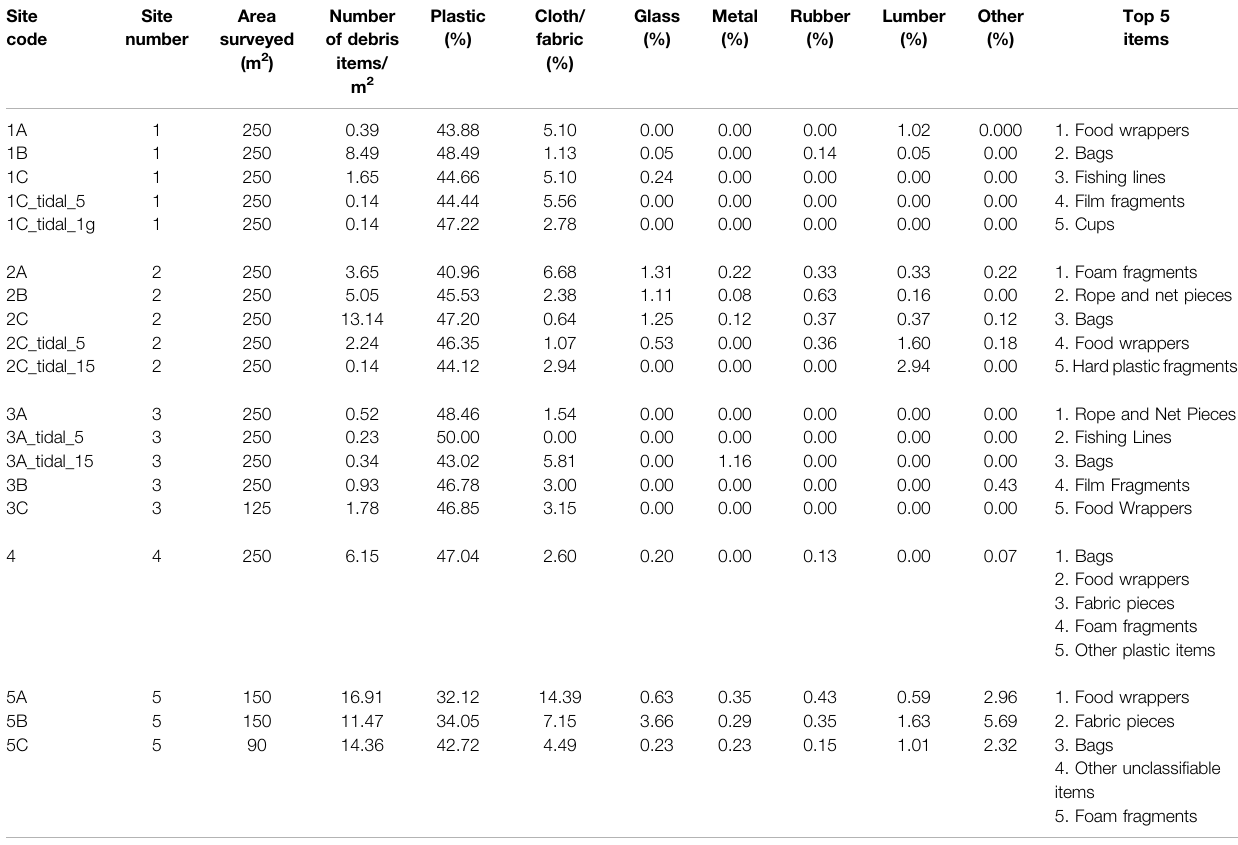
TABLE 1 | Summary of debris data across the fi ve sites and within the 19 transects surveyed. Site code